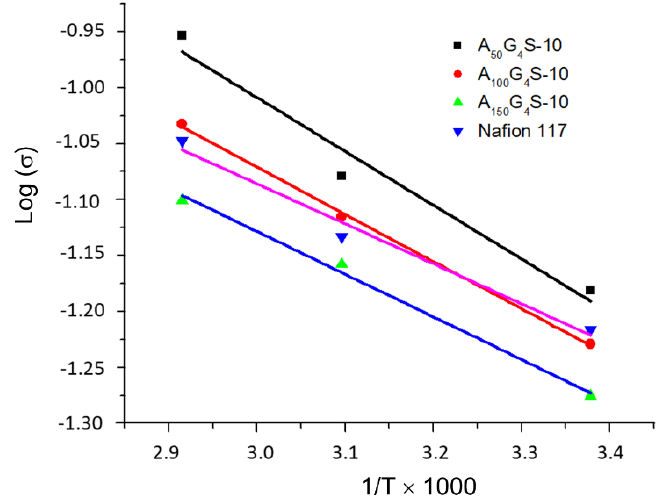
Figure 4. Arrhenius plot of proton conductivities of fully hydrated cross-linked diblock ionomer membranes and Nafion 117. Table 3. Activation energies of cross-linked diblock ionomer membranes. A Nafion 117 membrane is included for